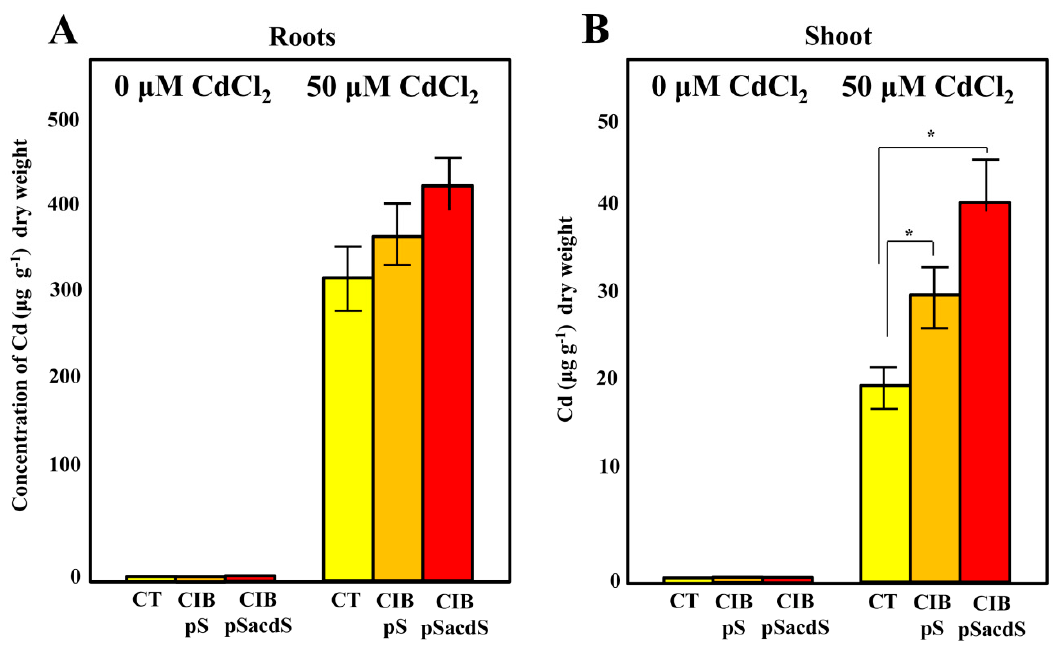
Figure 4. Cd concentrations in roots ( A ) and shoots ( B ) of rice. Rice plants inoculated with Azoarcus sp. CIB (pSEVA237) (CIB pS) (orange column), Azoarcus sp. CIB (pSEVA237acdS) (CIB pSacdS) (red column), or without bacterial inoculation (CT) (yellow column), were grown in substrates containing 0 µ M or 50 µ M CdCl 2 in greenhouse conditions as detailed in Section 2. Total Cd concentrations ( µ g / g dry weight) of the harvested plants were determined by ICP-AES. Presented are mean values for 5 plants with the corresponding errors. The asterisks indicate the statistical significance observed when the three conditions were compared applying the one-way ANOVA method and the Bonferroni